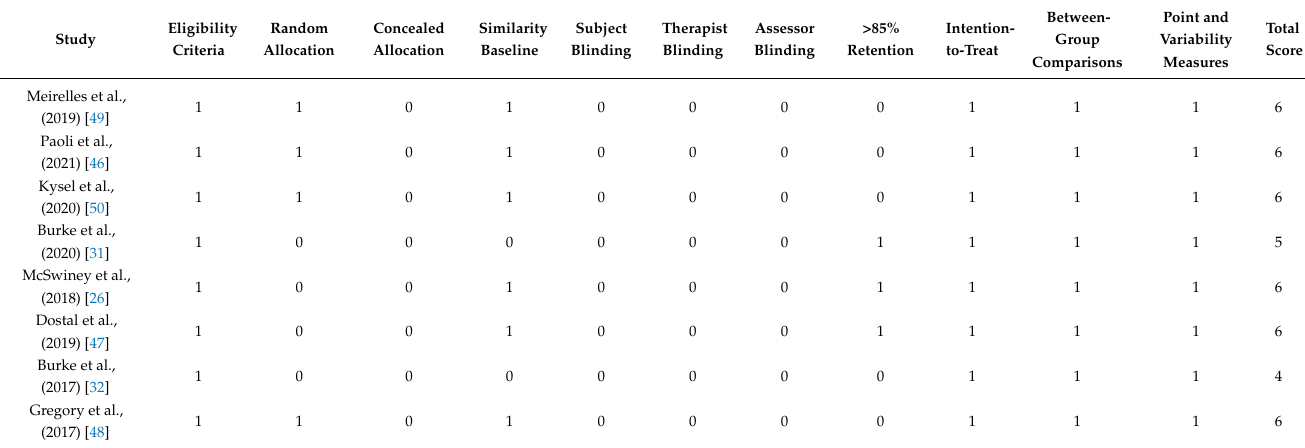
Table 2. Quality assessment of included studies (n =